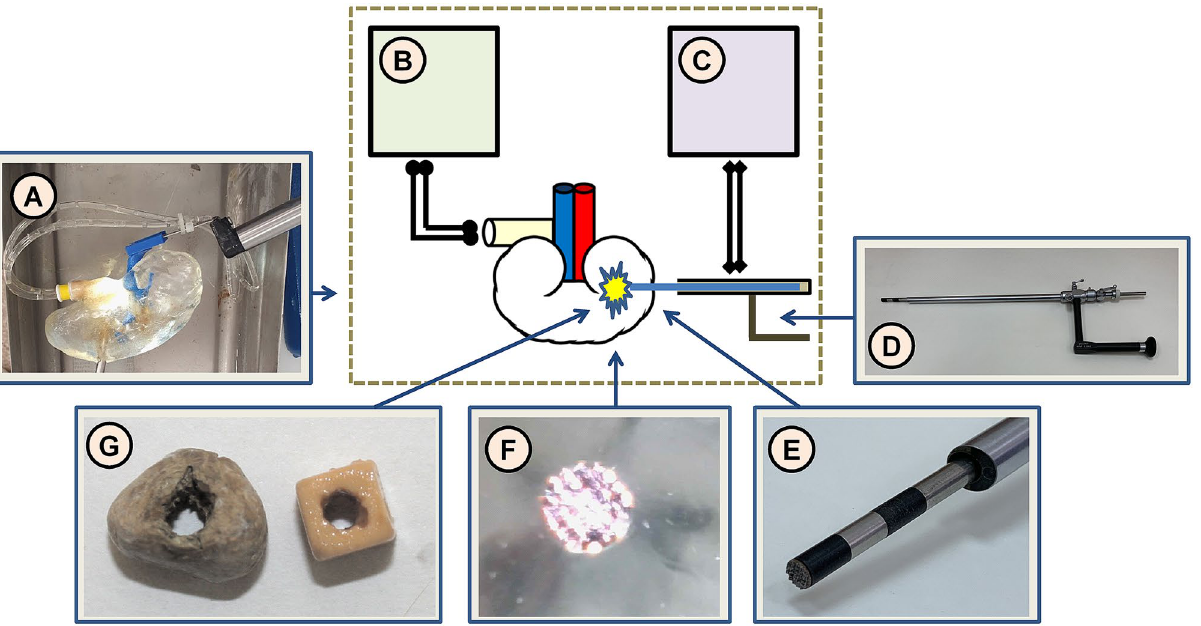
Figure 1. Scheme of the experimental setup: operational field of the experimental setup ( A ), a saline pumper ( B ), a high-frequency current generator ( C ), a urethroscope ( D ); distal part of the urethroscope for plasmakinetic lithotripsy: urethroscope and the plasma electrode ( E ); plasma generation on the distal part of the probe ( F ); the samples of a dummy kidney stone and a natural kidney stone after plasma treatment ( G